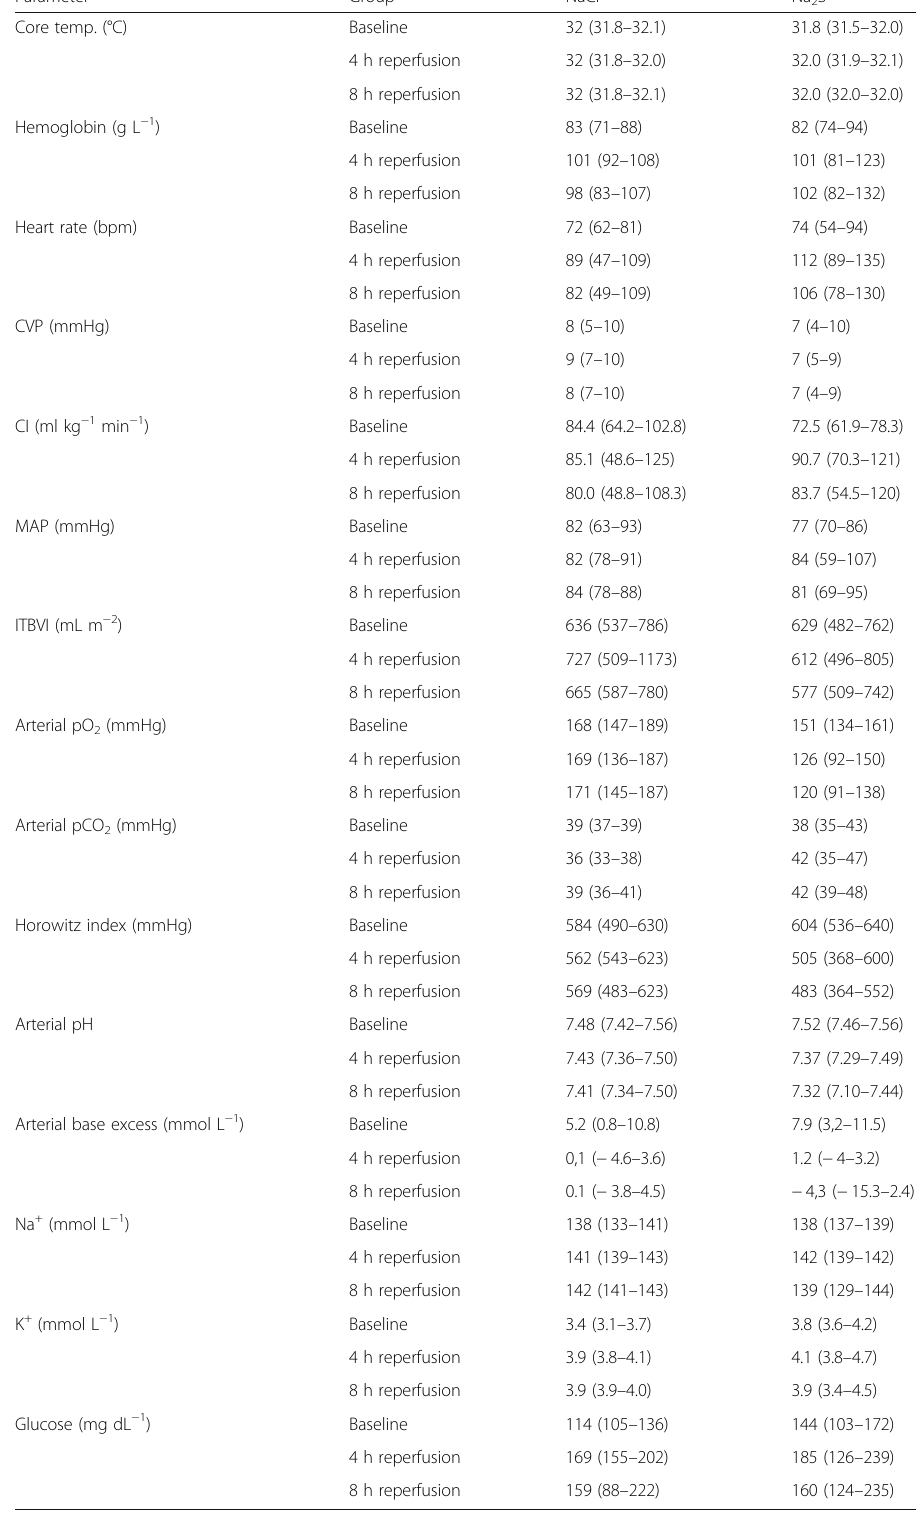
Table 1 Systemic hemodynamic, gas exchange, and acid-base